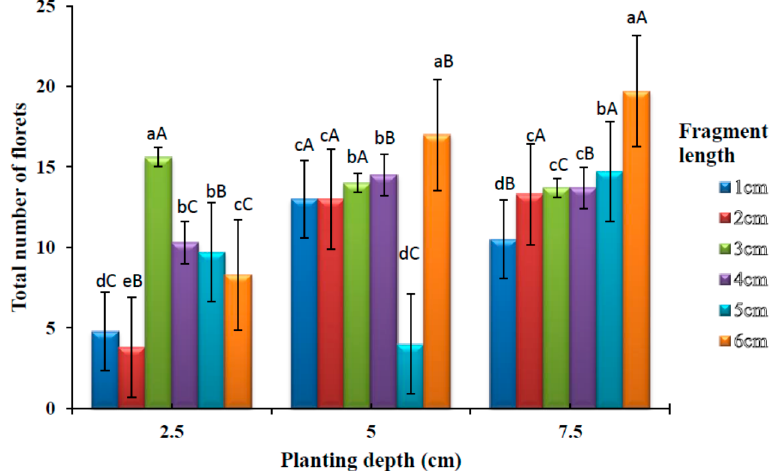
Figure 6. Effects of varying planting depths and rhizome fragment lengths on the number of florets. Bars with different lowercase superscripts(a > b > c > d > e) in the same groups of planting depth are significantly different ( p < 0.05) while bars with different uppercase superscripts (A > B > C) within a fragment length in the different groups of planting depth (2.5, 5 and 7.5 cm) are significantly different ( p < 0.05). Table 2. E ff ects of planting depths and fragment lengths production on the rhizome length gain.